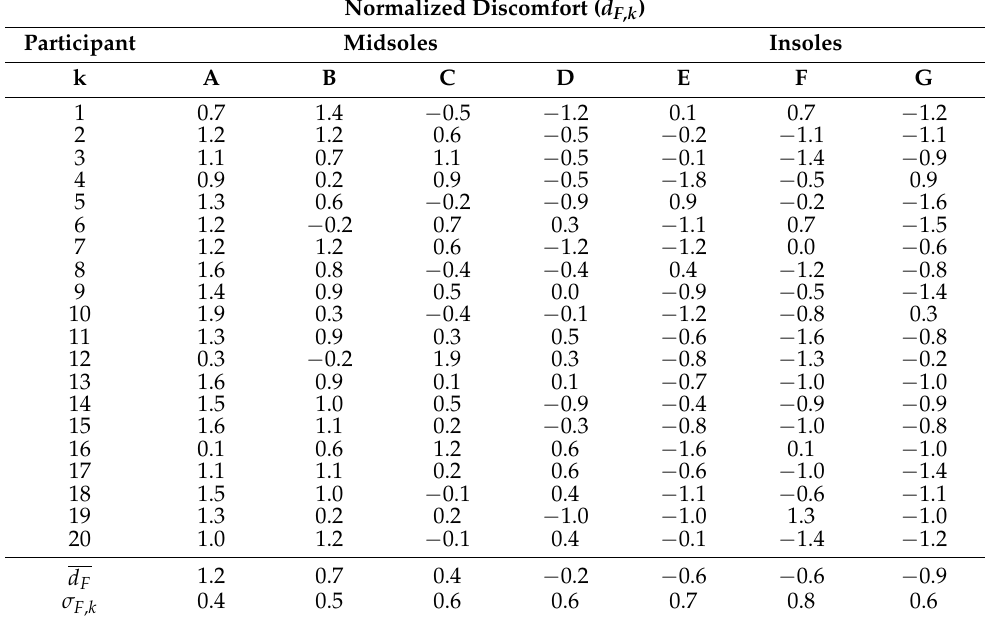
Table 3. Normalized discomfort reported by all the